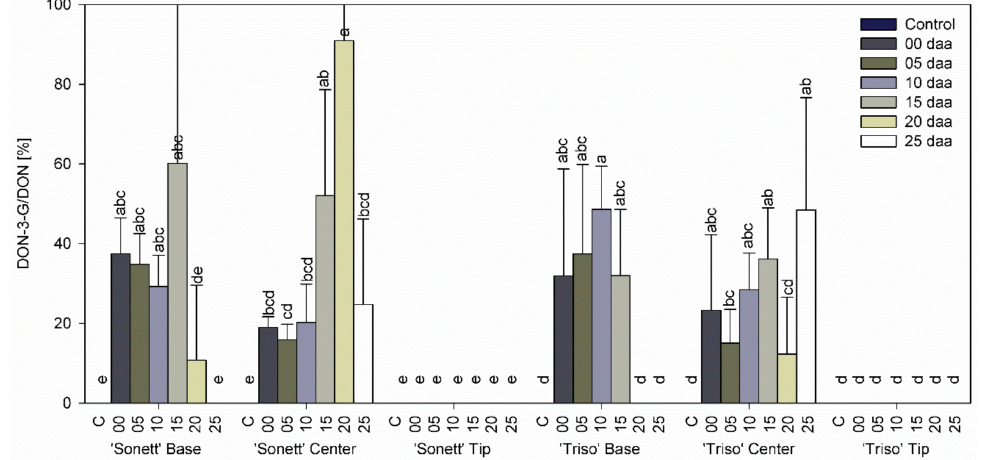
Figure 5. Deoxynivalenol-3-glucoside /deoxynivalenol ratio in the tips, centers, and bases of the spikes of spring wheat varieties ‘Sonett’ and ‘Triso’ after inoculation of the central spikelets of the spike with Fusarium graminearum at different days after anthesis (daa), Kruskal–Wallis test ( p < 0.0001); n = 6. n = 6; treatments with the same letters at the level of the variety are not significantly